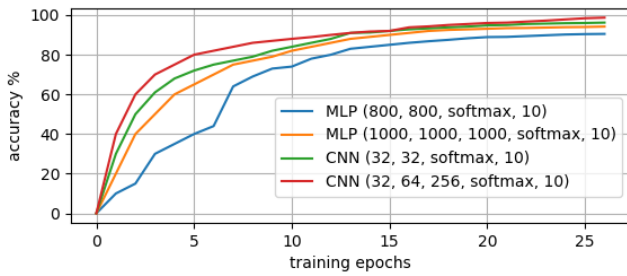
Figure A1. Accuracy comparison between MLP and CNN.